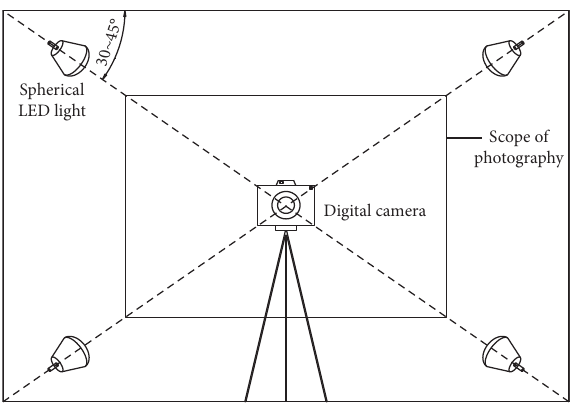
Figure 2: Schematic diagram of light source layout.